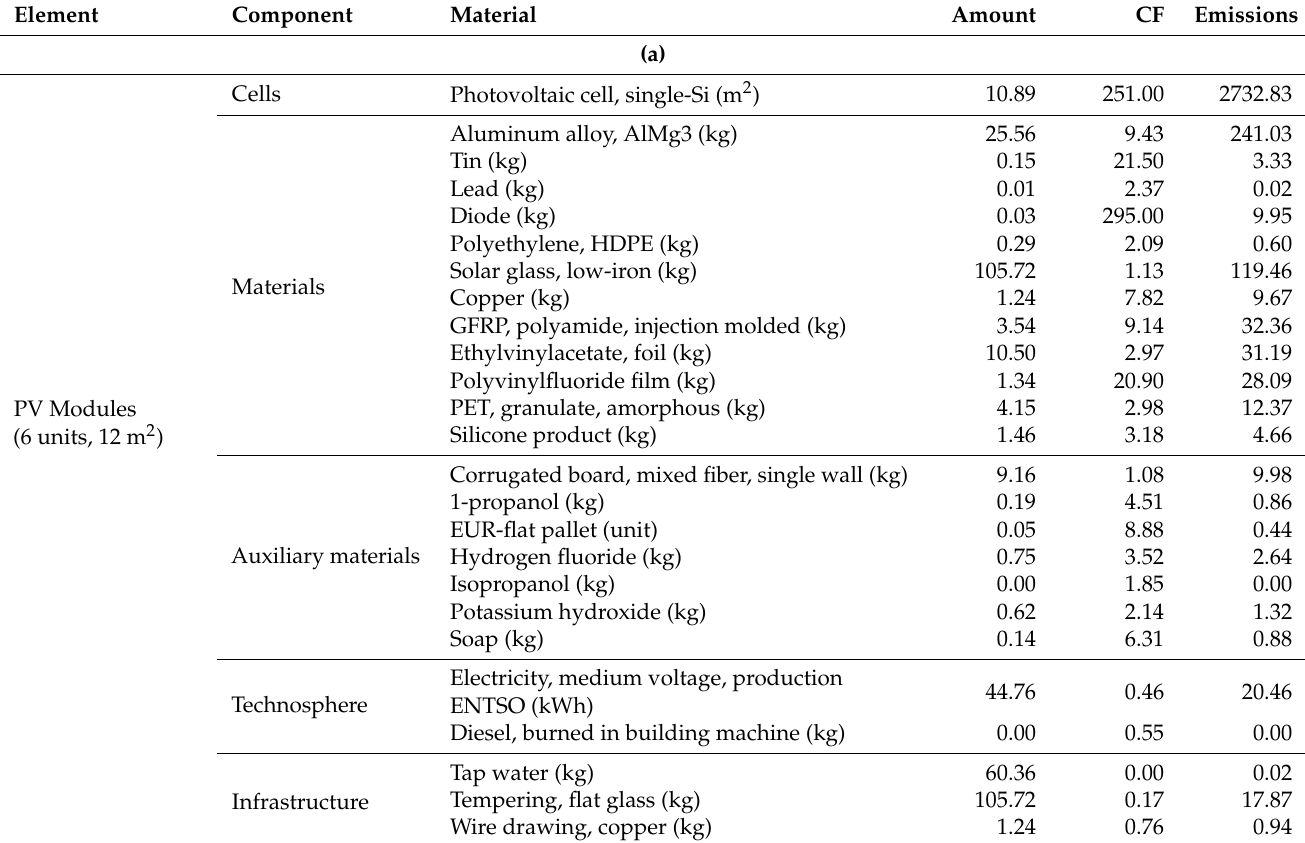
Table 8. ( a ) Manufacture emissions from PV system. ( b ) Manufacture emissions from PV